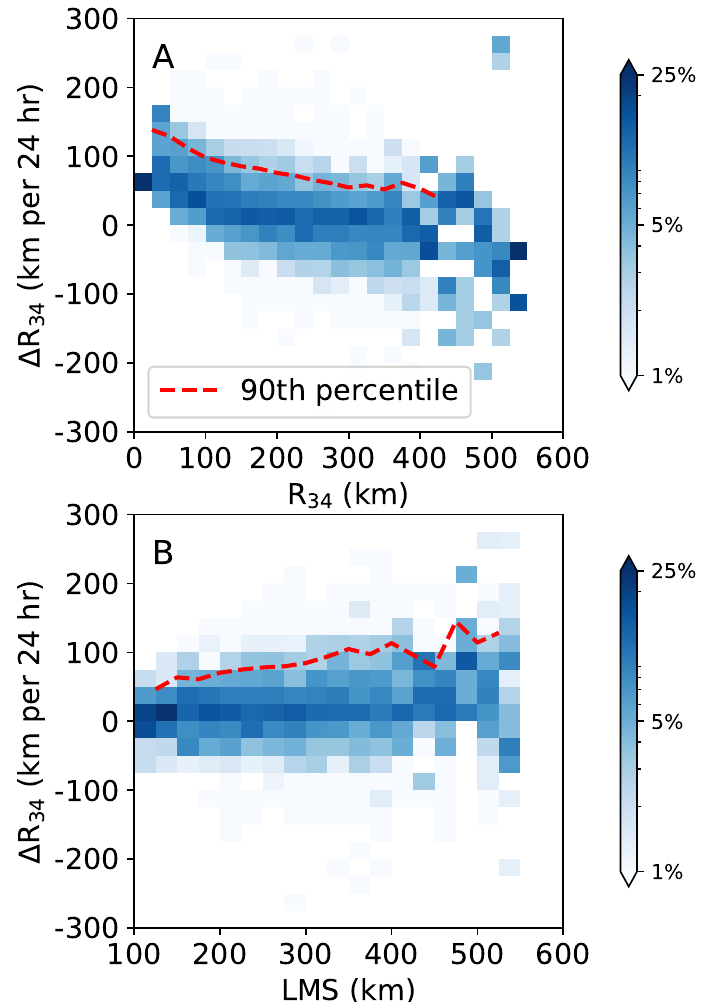
Figure 2. The ratio of 24 h R 34 changes as a function of ( A ) the initial R 34 during each 24 h interval and ( B ) the lifetime maximum size (LMS) for the western north Pacific. The y -axis in each subplot relates to the 24 h R 34 changes (units: km/24 h) and the x -axis shows the initial R 34 and LMS (units: km). The unit for the blue shadings is %. The red line shows the 90th percentile for each